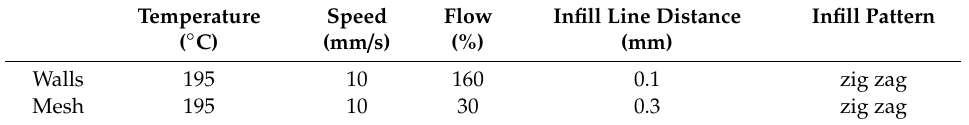
Table 2. Optimized printing parameters for filamentary net structures compared to wall printing parameters.